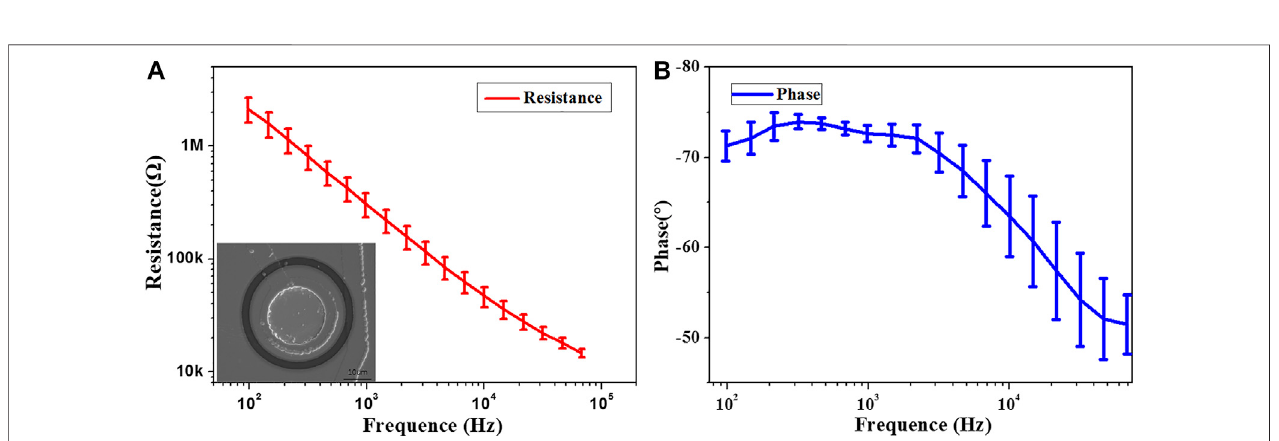
FIGURE 5 | Characterization of optrode electrical properties (A) Impedance, illustration is the SEM of the electrode point. (B) Phase.